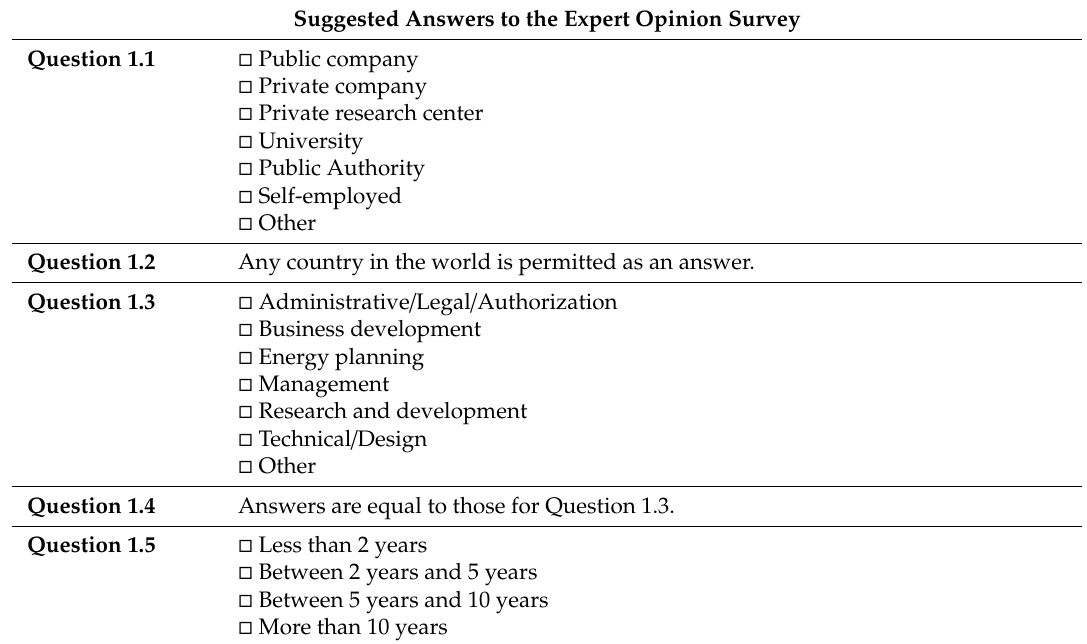
Table A2. The expert opinion survey